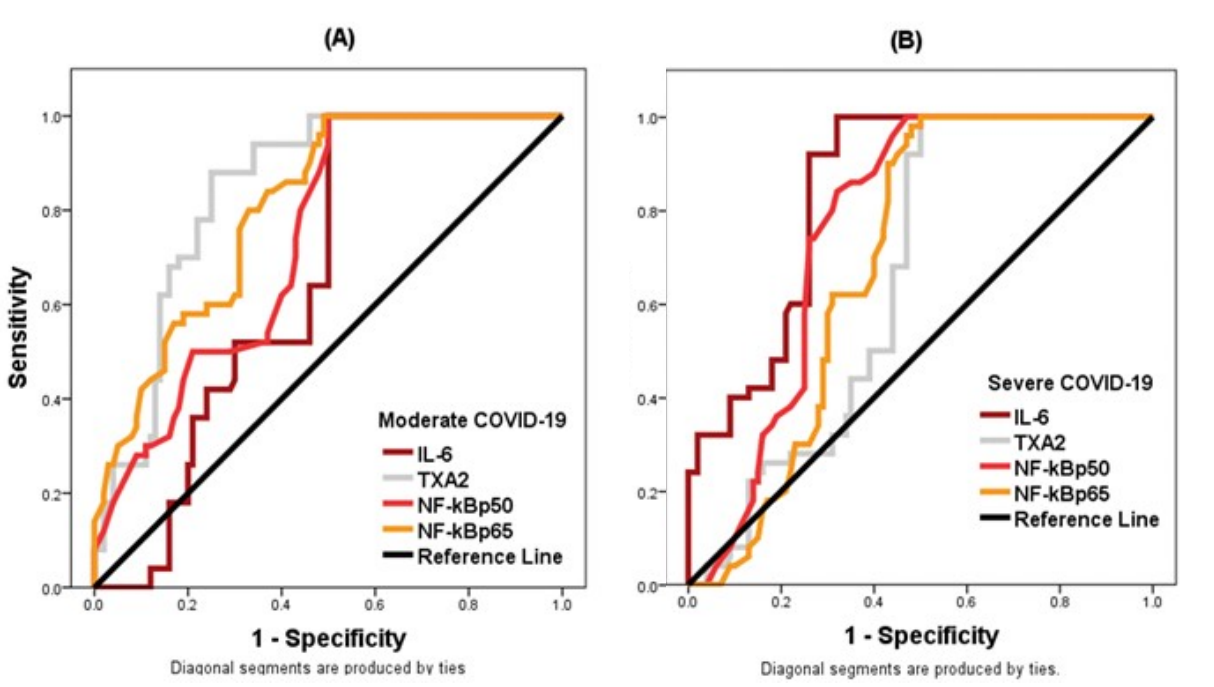
Figure 2. ROC curves of laboratory biomarkers as predictors of disease in the moderate group ( A ) and in the severe group ( B